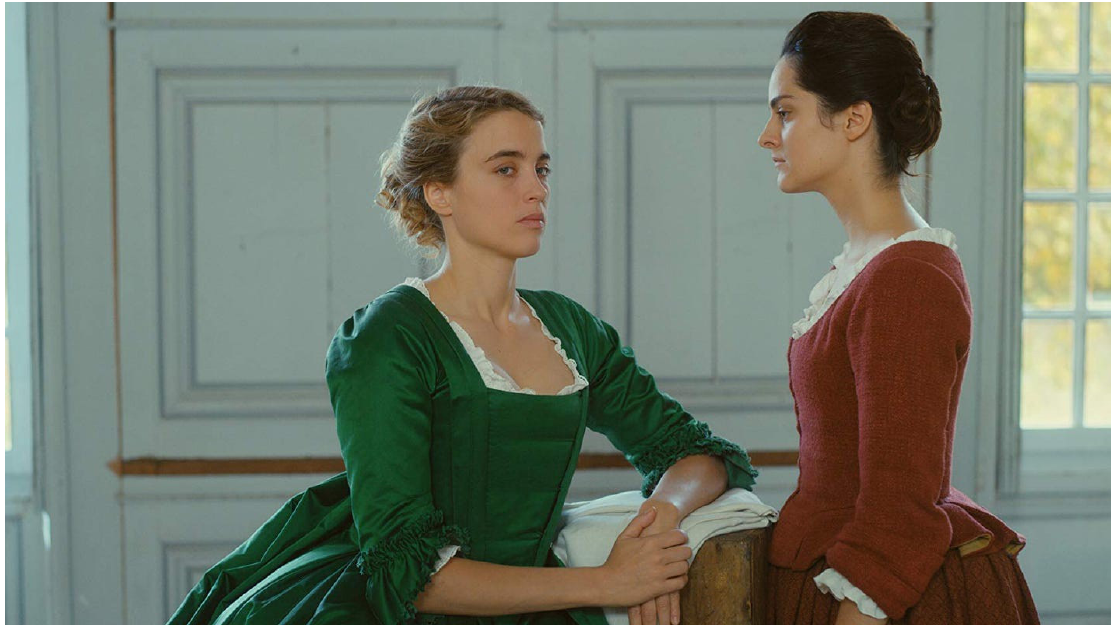
Figure 1. Marianne arranges Héloïse during the sitting in Portrait of a Lady on Fire, dir. Céline Sciamma (2019). Screenshot © Lilies Films.